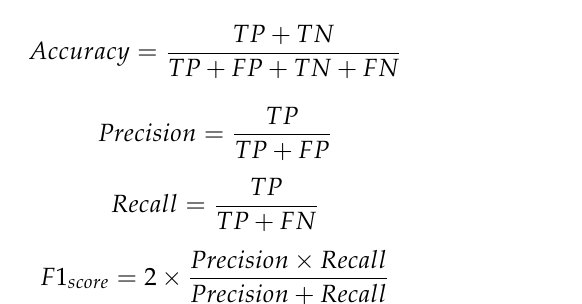
Table 3. Fecal Coliform and its Class.